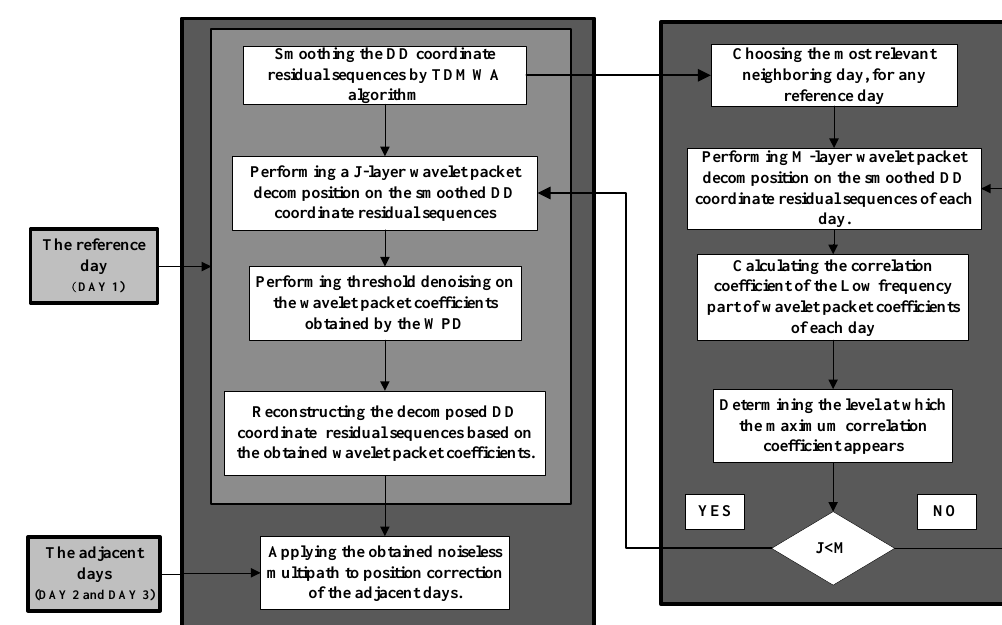
Figure 2. The overall program of mitigating the multipath in GPS static high-precision positioning.